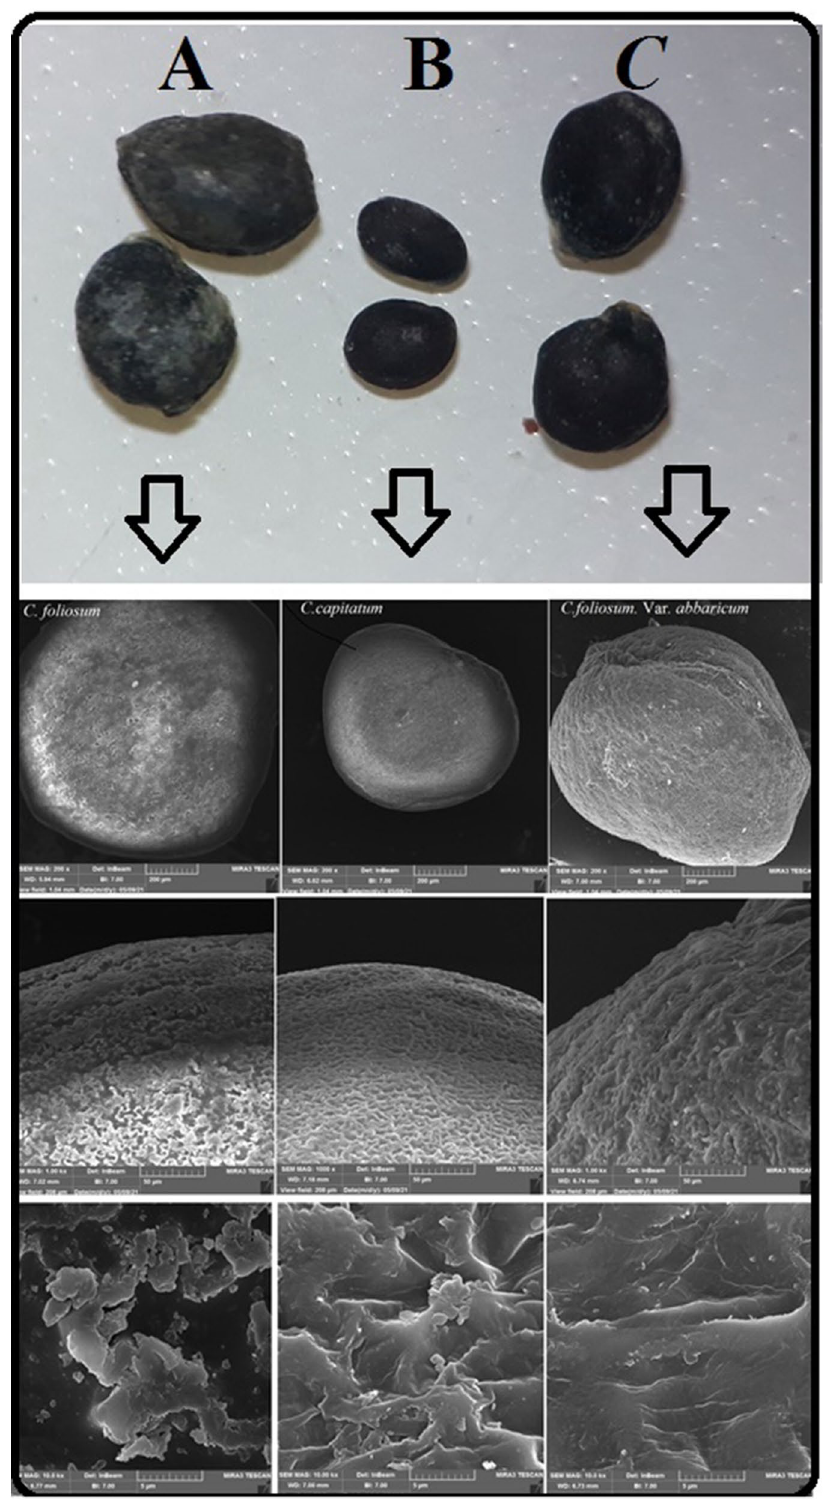
Figure 7. Differences in seed coat ornamentals in the three species studied by scanning electron microscopy (SEM). ( A ) Chenopodium foliosum ( syn. Blitum virgatum ), ( B ) Chenopodium capitatum & ( C ) Chenopodium foliosum |abbaricum| (MSP). The SEM characteristics were used for identifying three